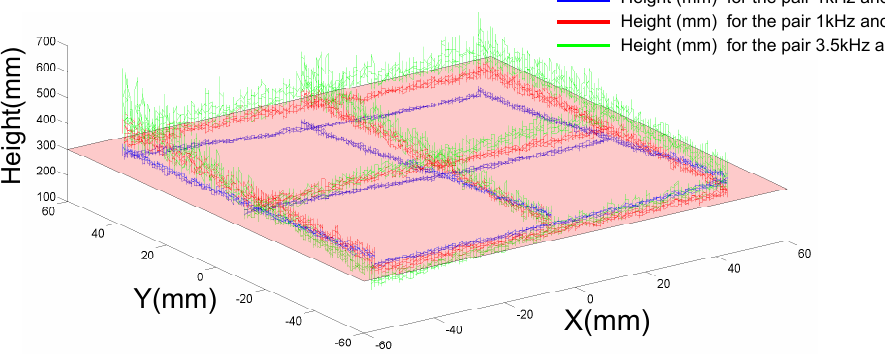
Figure 15. Height estimation for three pairs of LEDs and with a 10-cm shift in the X and Y directions. Note that a small coupling appears on the height estimation with respect to the position of HyperCube in the XY